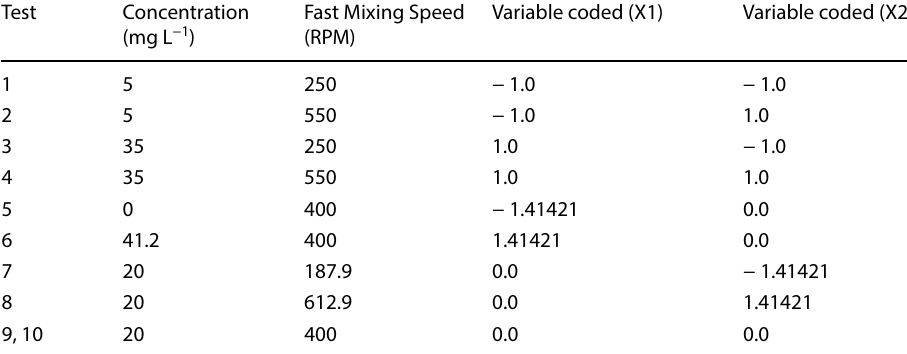
Table 1 Results of the experiments of the central composite design for concentration and rapid mixing speed of the coagulant Tanfloc SG®